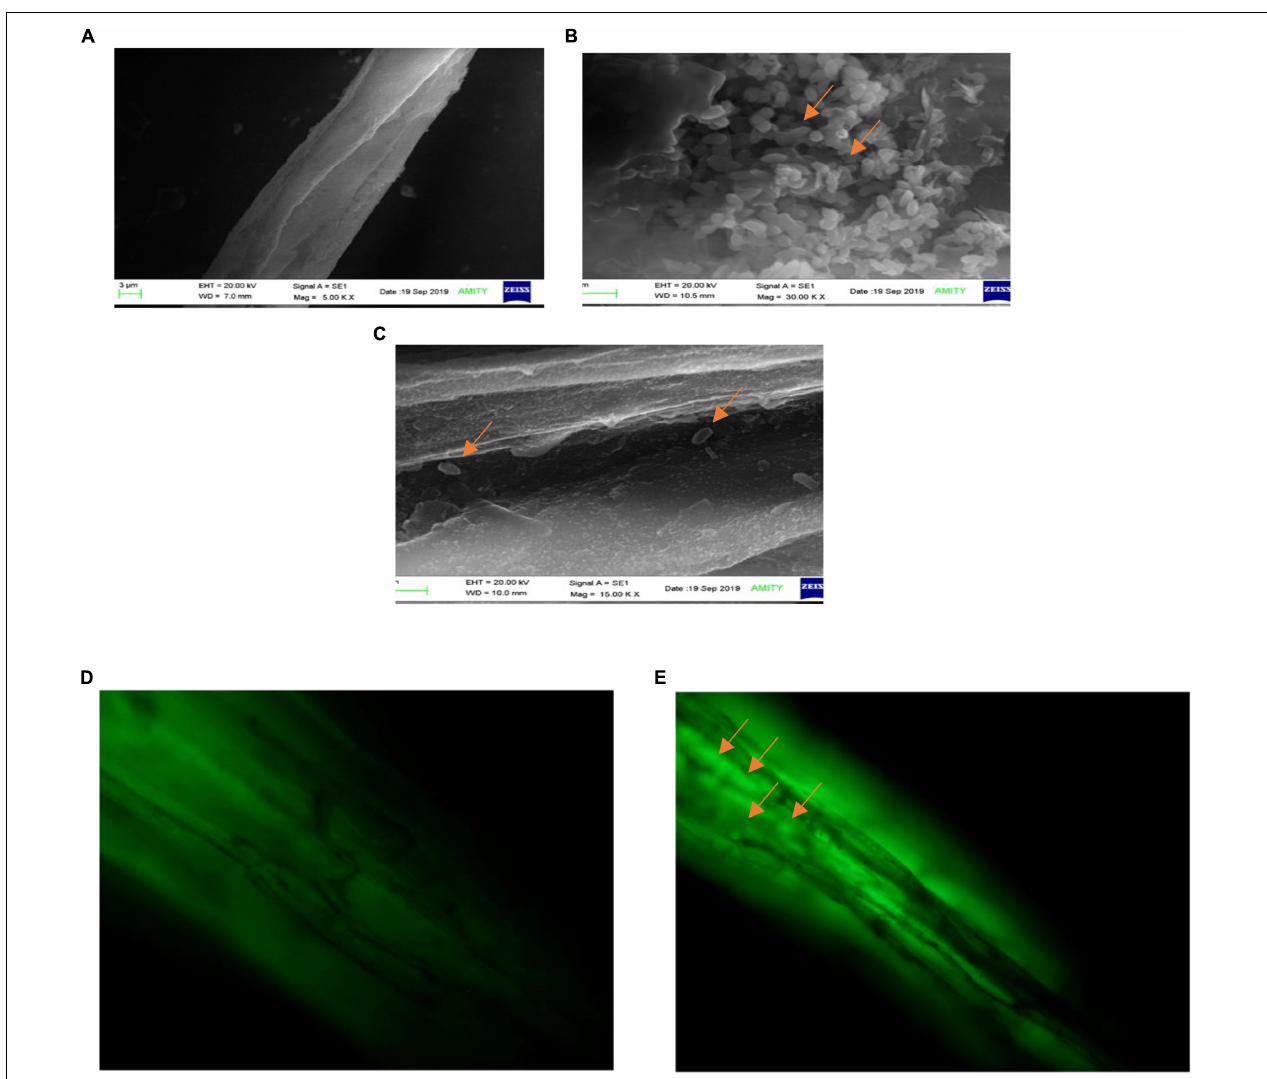
FIGURE 12 | Scanning electron microscopic analysis of pea plant roots inoculated by consortia of Pseudomonas aeruginosa OS_12 and Aneurinibacillus aneurinilyticus OS_25 (A–C) . (A) Roots of non-inoculated pea plants, (B) bacterial cells (arrows) swarming in the vicinity of rhizoplane, (C) bacterial cells (arrows) in the intercellular space between epidermis and cortex of root system. Scale bar equals 3 µ m (A) , 1 µ m (B) , and 2 µ m (C) . Fluorescent microscopy images of root sections stained with acridine orange (D,E) . (D) Control pea root sample without any inoculation, (E) root section of consortium inoculated pea plant with arrows pointing bacterial cells inside the epidermis (bar equals 10 µ